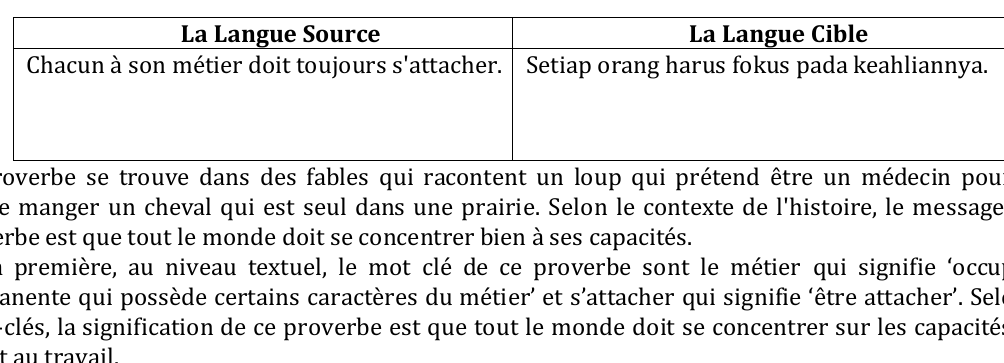
Tableu 2 La traduction est la